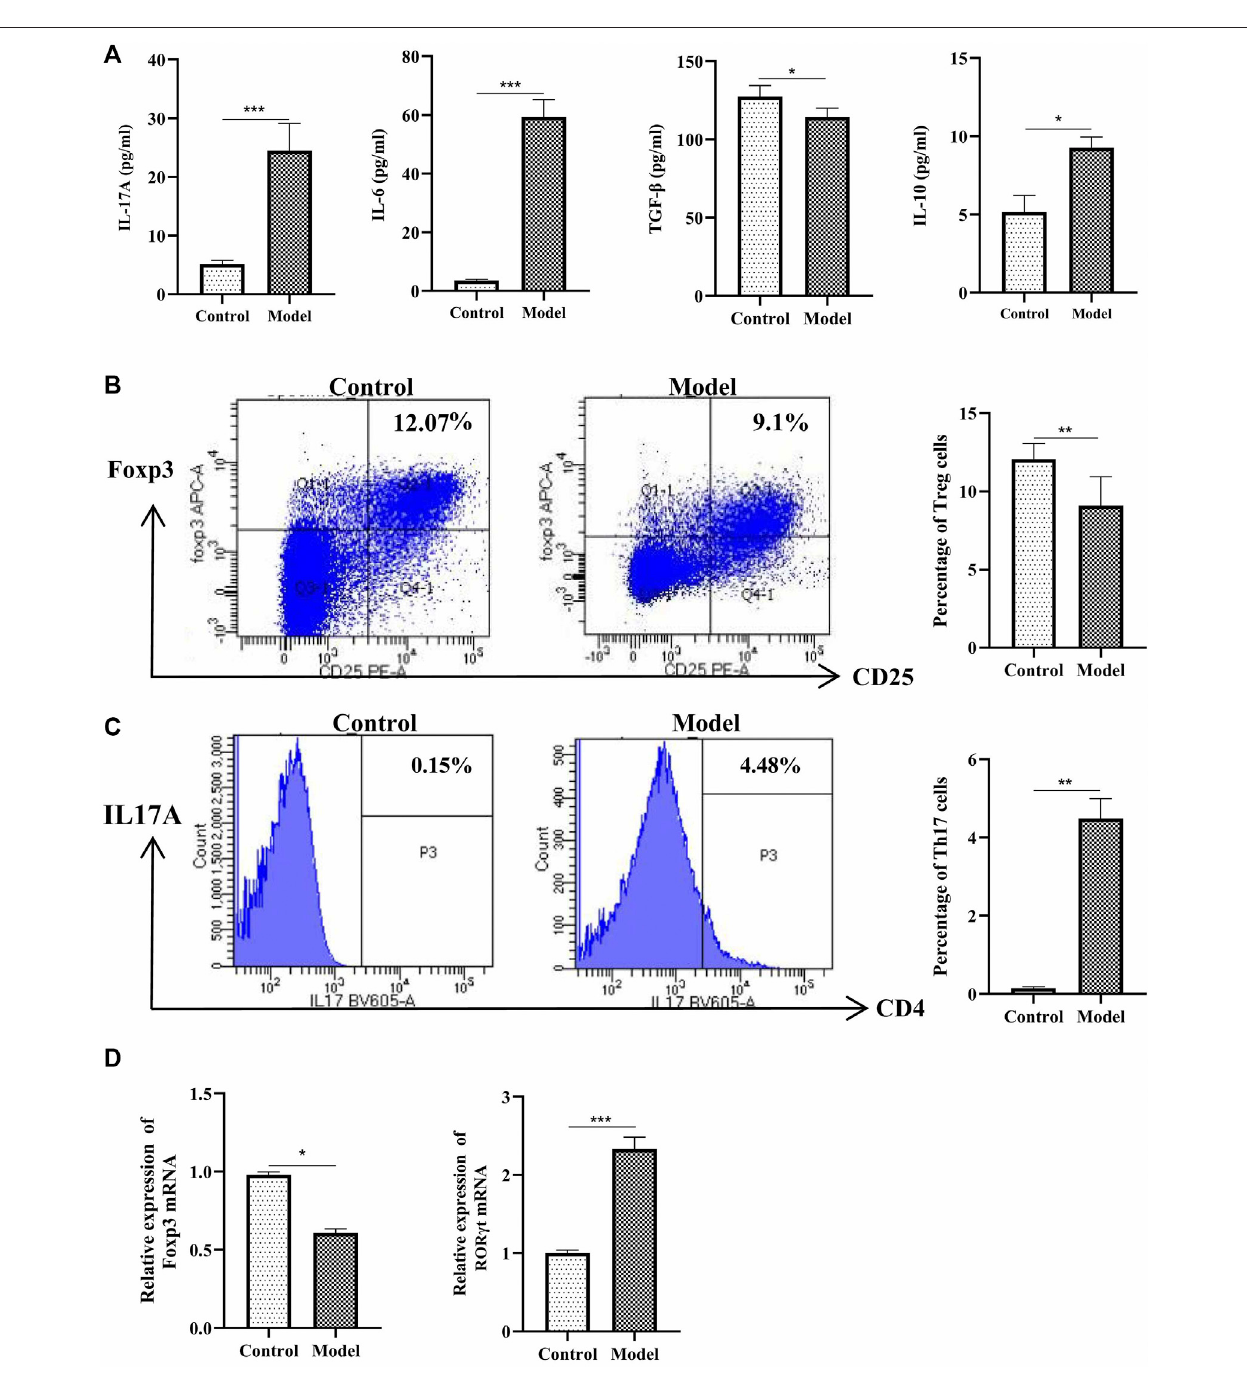
FIGURE 3 | Detection of Treg and Th17 cells. (A) Detection of IL-17A, IL-6, TGF- β and IL-10 in BALF, BALF was collected 24 h after last challenge, they were detectedasdescribedintheprotocol; (B) Left:IntracellularstainingofCD25andFoxp3inthedoorCD4 + Tcells24 hafterchallenge;Right:StatisticdataofTregcells24 h after challenge; (C) Left: Intracellular staining of IL17A and CD4 in the door CD3 + T cells 24 h after challenge; Right: Statistic data of Th17 cells 24 h after challenge; (D) Relative expression ofFoxp3 mRNAand ROR γ tmRNAdetected byRT-qPCR.* p < 0.05, ** p < 0.01, *** p ≤ 0.001.All thevaluesareexpressed asmean±SEM. n = 4,5 animals per